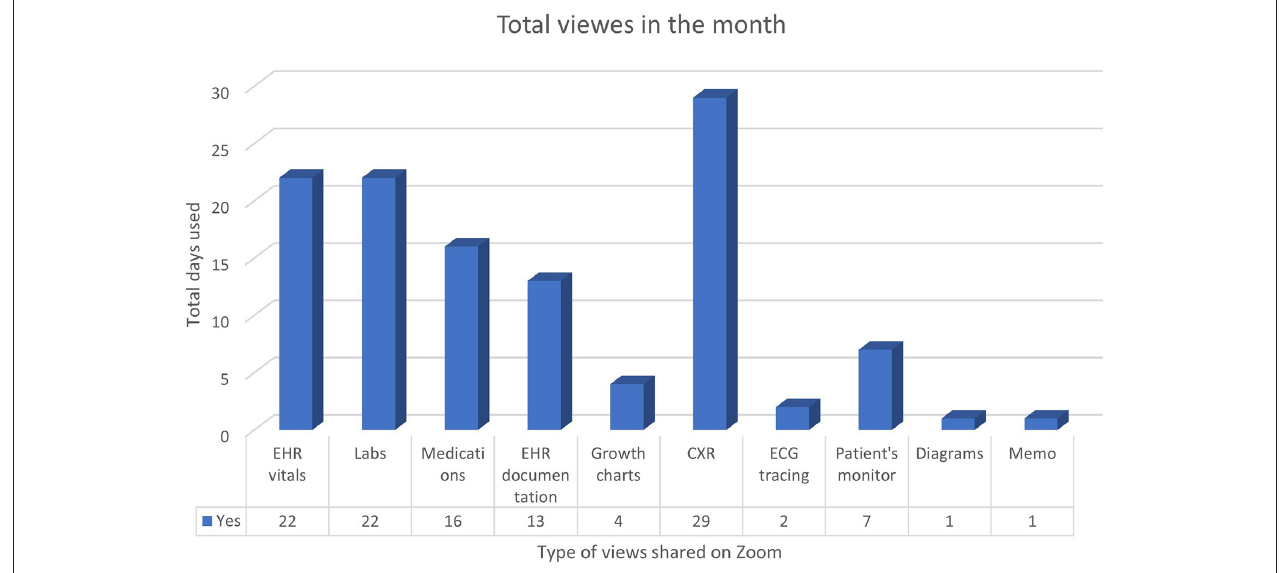
FIGURE 3 | Total views per type shared on the Zoom round over the month. EHR, electronic health records; CXR, chest